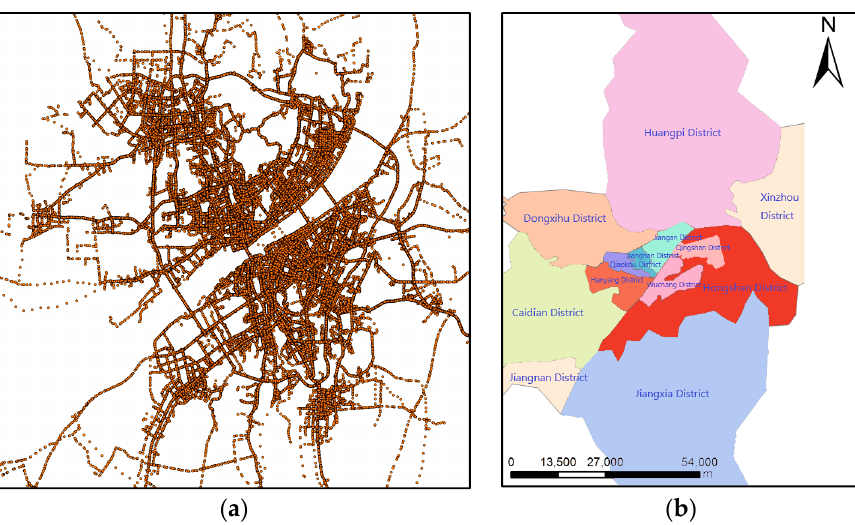
Figure 6. Experimental datasets: ( a ) taxi trajectories collected in a workday in the city of Wuhan, China; ( b ) the administrative map of Wuhan city.